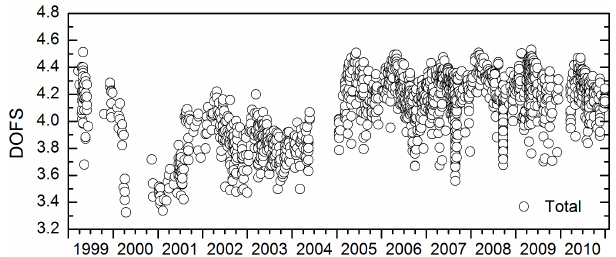
Table 3. Assumed experimental and temperature